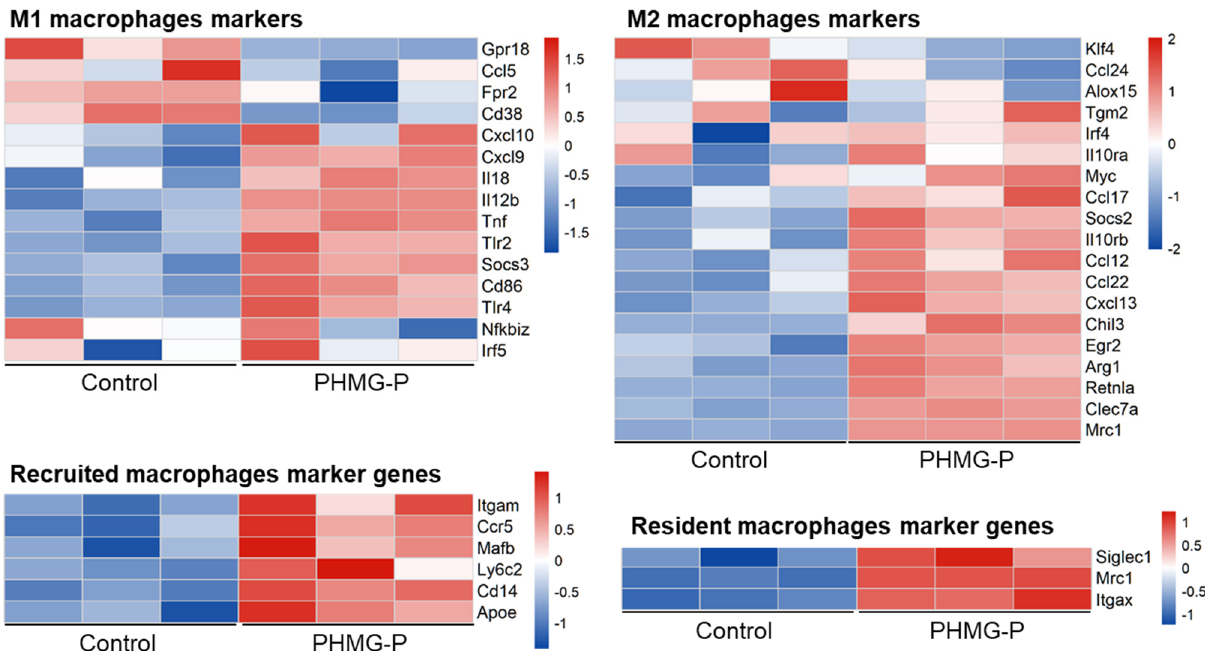
Figure 6. The expression pattern of macrophage polarization and residence-related markers in the control and the PHMG-P-treated groups.